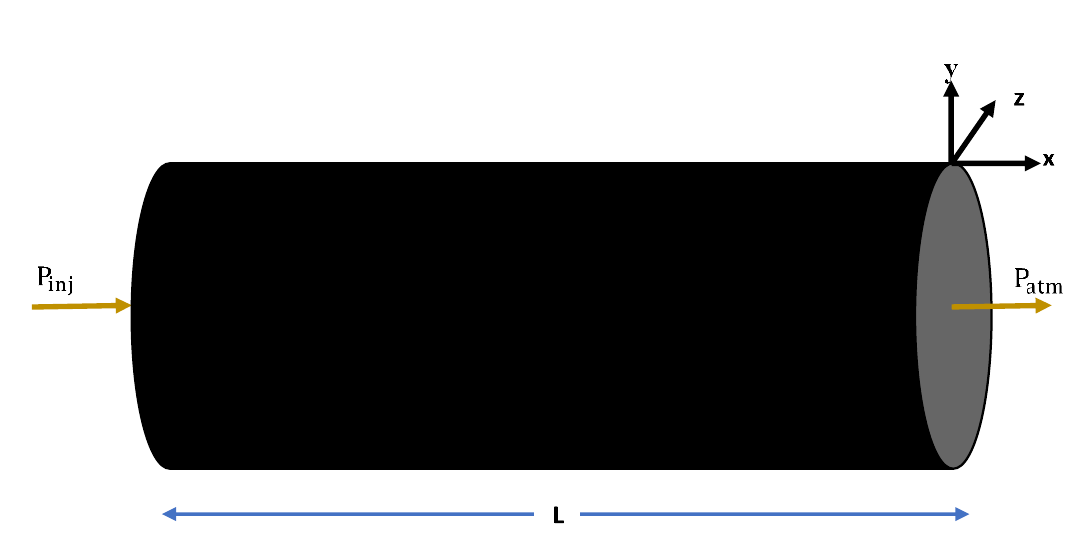
Figure 1. One-dimensional (1D) gas flow through a porous media of length, L.